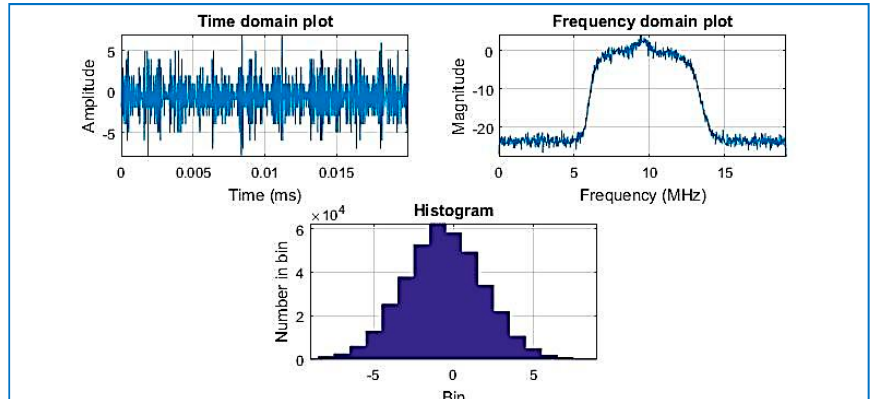
Figure 7. Compressed signal with R = 0.025, Dataset 1.